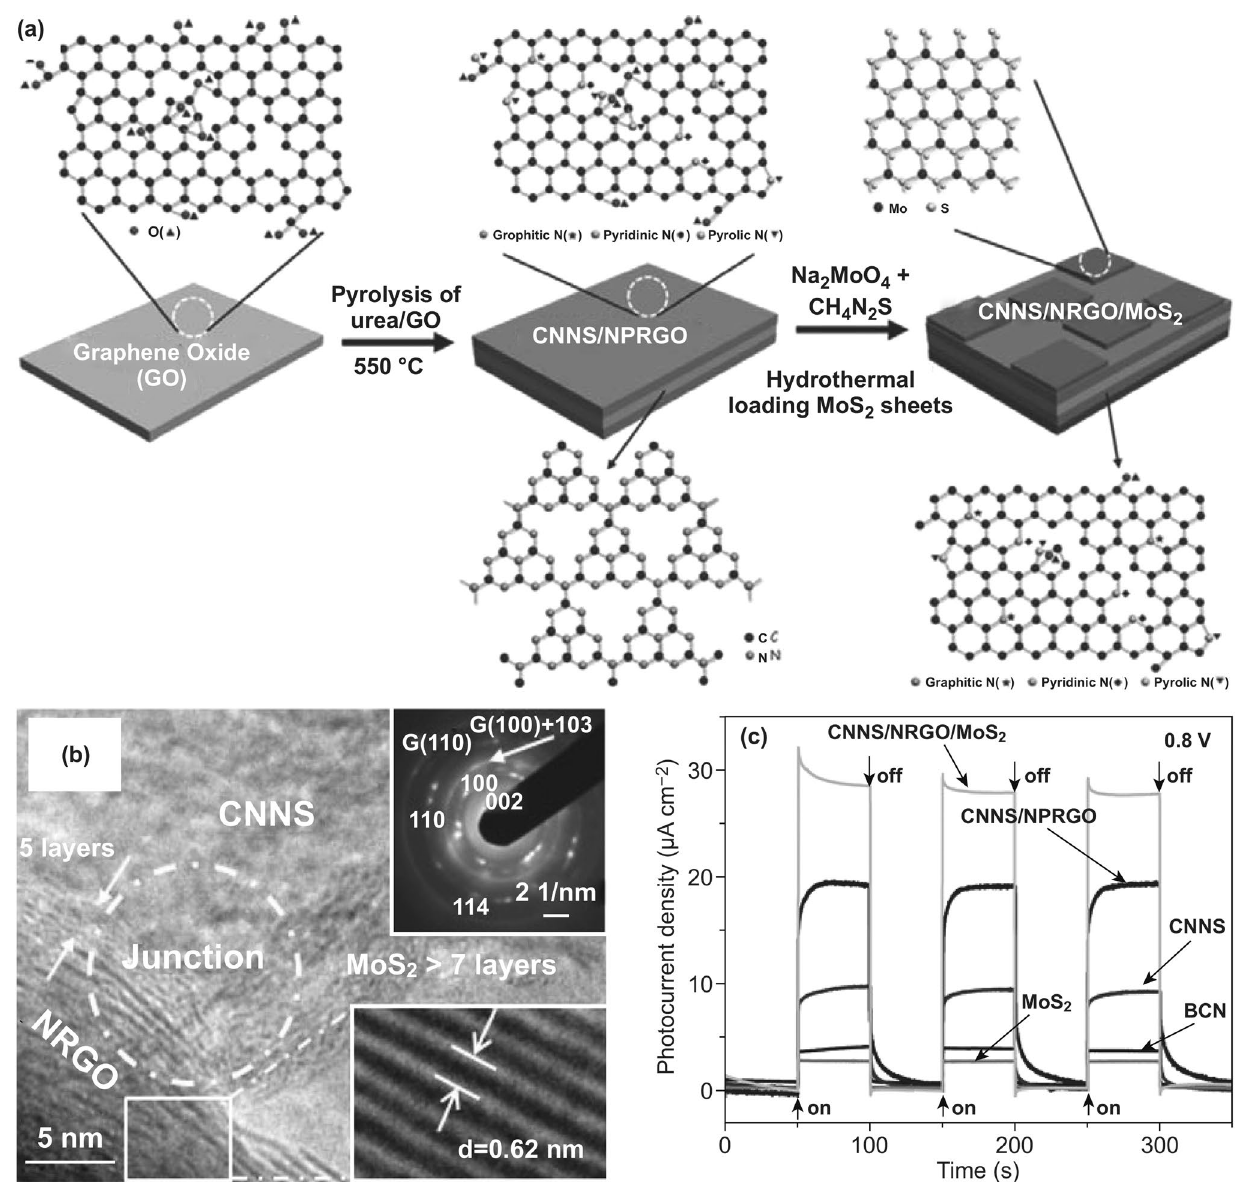
Fig. 3 a Synthetic scheme of CNNS/NRGO/MoS 2 . b HRTEM image of CNNS/NRGO/MoS 2 . c Transient photocurrent density vs. time plotted for BCN, MoS 2 , CNNS, CNNS/NPRGO, CNNS/NRGO/MoS 2 . Reproduced with permission from Ref. [88]. Copyright 2013